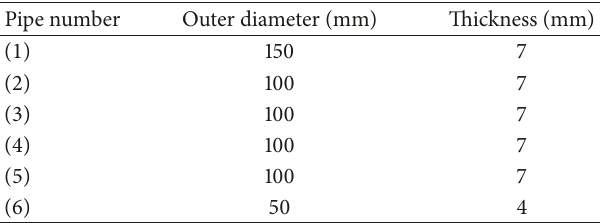
Table 1: Outer diameter and thickness of